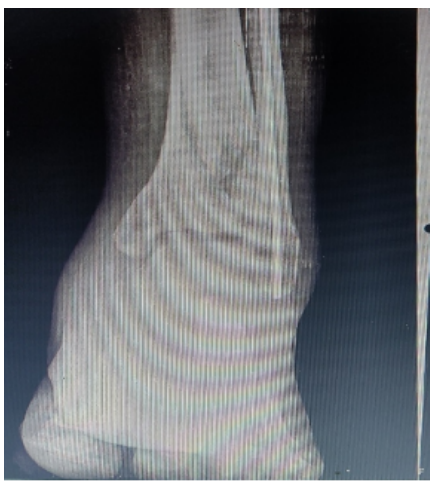
Figure 7. removal of external fixator after 4 month-AP